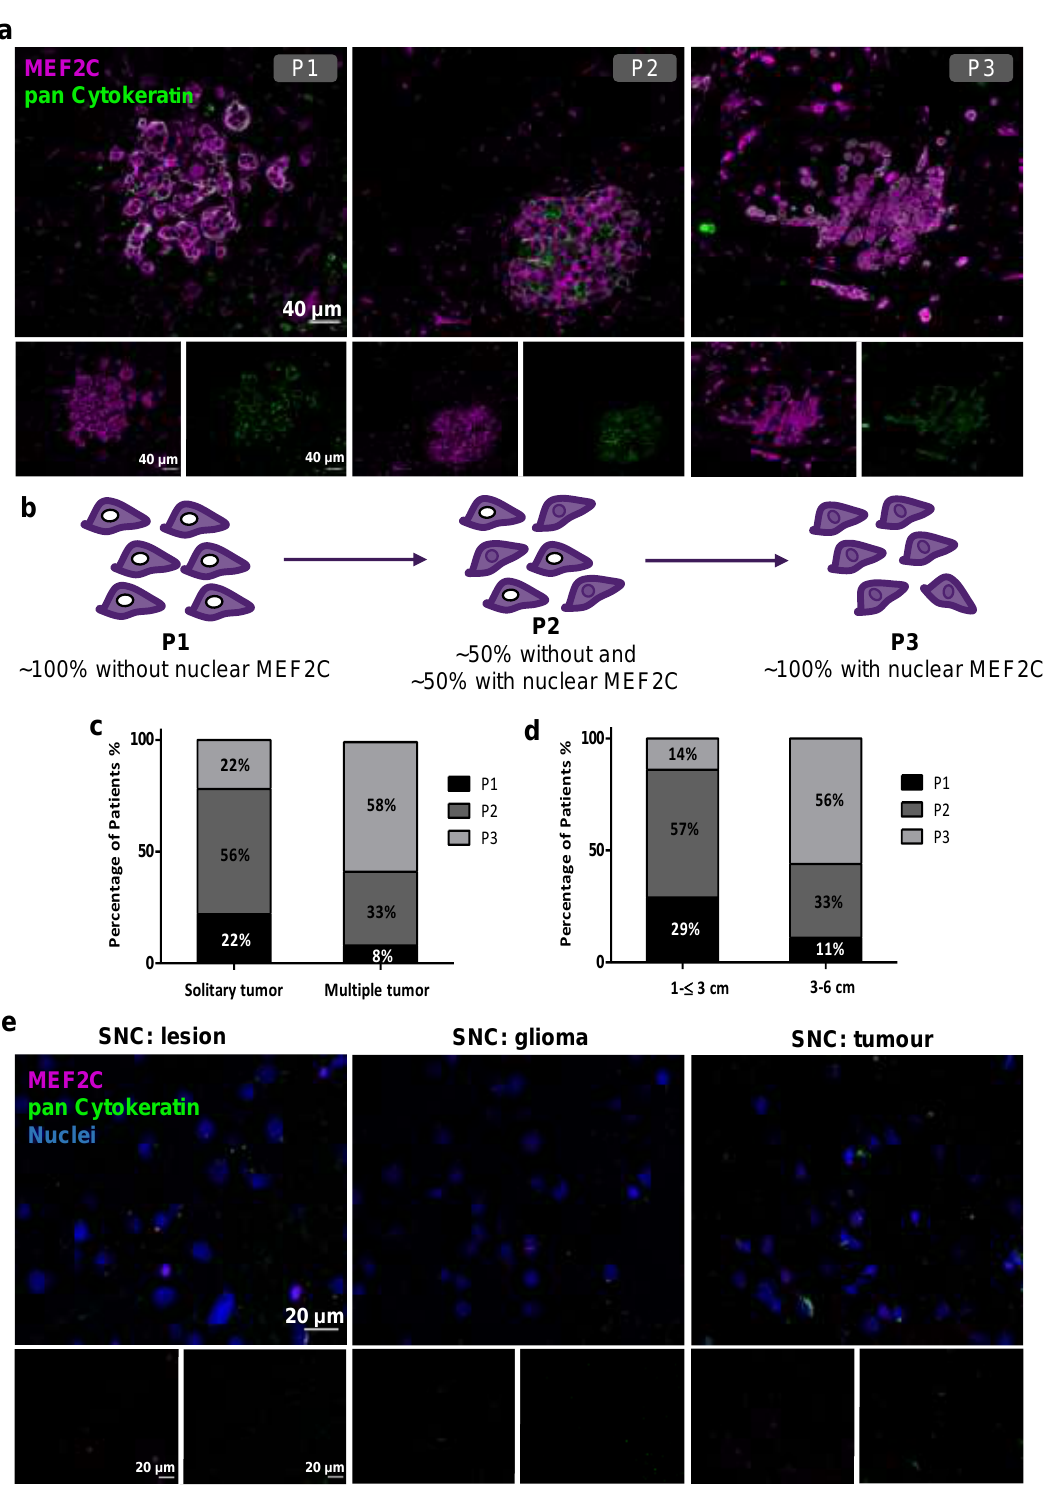
Figure 1. Myocyte Enhancer Factor 2C expression in resected human brain metastases derived from breast cancer patients and from glioma patients. Immunofluorescence analysis of myocyte enhancer factor 2C (MEF2C) (purple) and of the